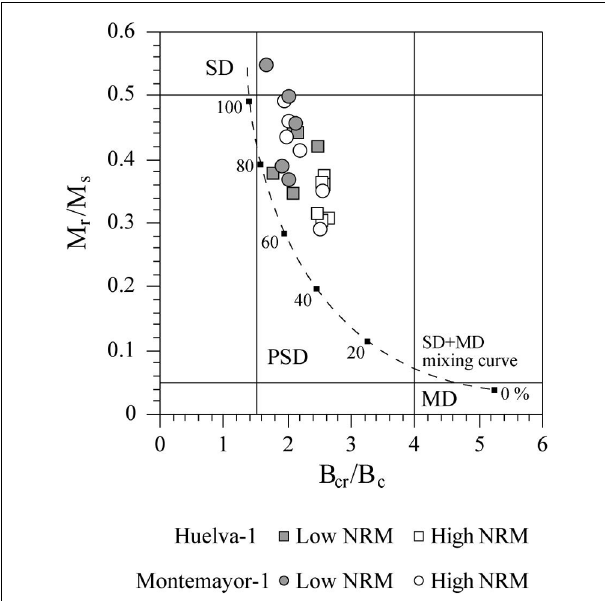
FIGURE 7 | Magnetic hysteresis results from the Huelva-1 and Montemayor-1 boreholes plotted on a Day diagram (Day etal., 1977). The line represents a theoretical mixing curve for MD particles at variable percentages (black squares) with uniaxial SD magnetite (Dunlop, 2002).The SD, PSD, and MD labels denote the fields for single-, pseudosingle- and multi-domain particles (Day etal.,